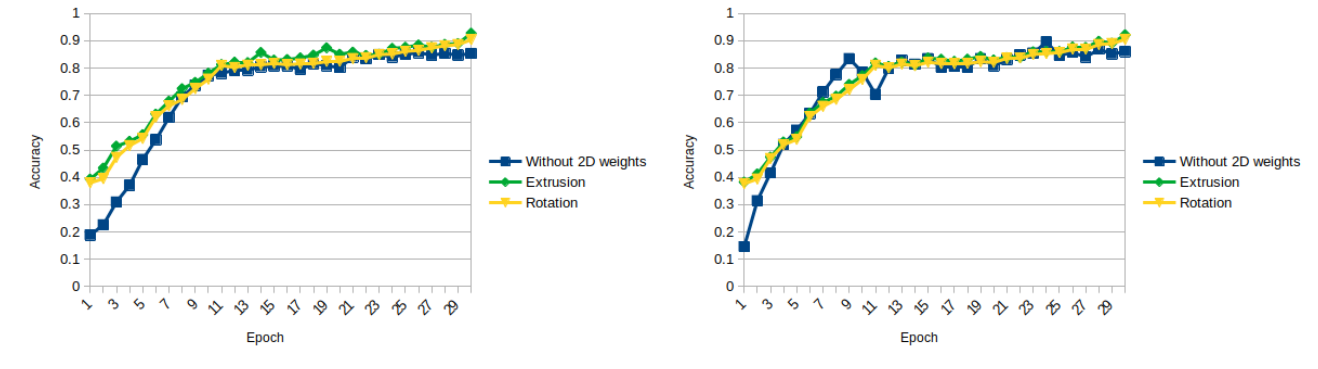
Figure 15. EfficientNetB0 3D Loss (Categorical Cross-Entropy).